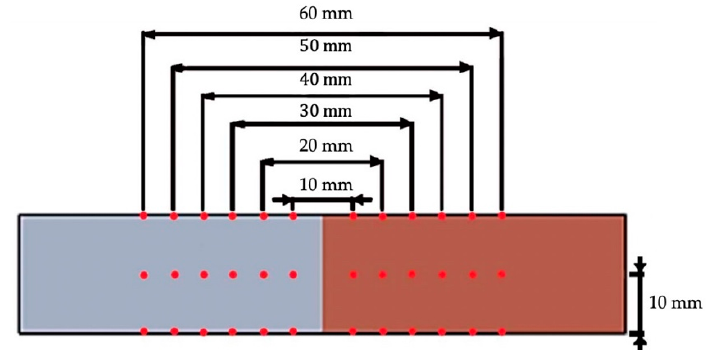
Figure 4. Schematic electrical resistance measurements in plates joined.